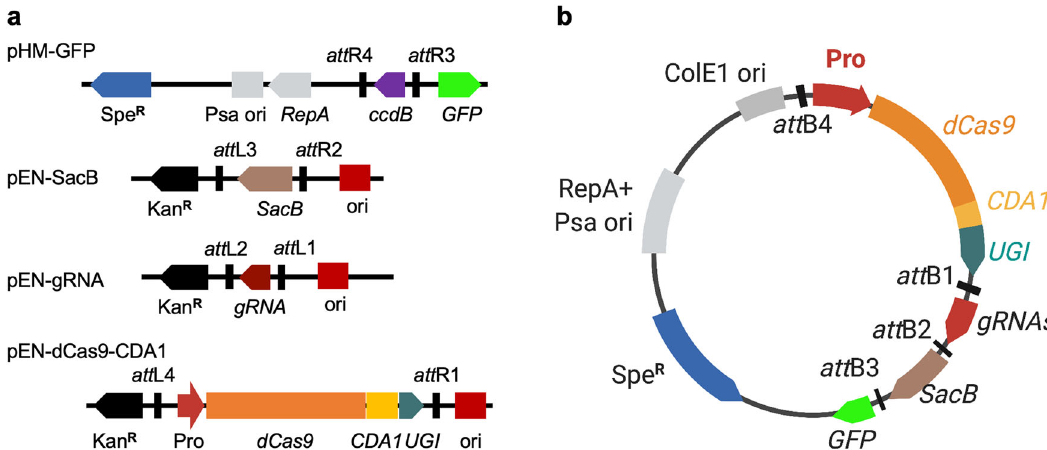
Fig. 1 Phytopathogenic bacterial cytidine base editor system. a A four-module system to make gene speci fi c cytidine base editor. Expression cassettes of guide RNA (gRNA), SacB , and chimeric gene of dead Cas9 (dCas9), cytidine deaminase (CDA1) and DNA uracil glycosylase inhibitor (UGI) each are fl anked by the Gateway recombination motifs ( att R and att L). b Schematic map of single construct expressing dead Cas9 deaminase, guide RNA expression cassette and GFP. Pro, promoter derived from Xanthomonas . dCas9, a nuclease dead Cas9; CDA1 P. marinus cytidine deaminase, UGI uracil DNA glycosylase inhibitor, gRNA guide RNAs, SacB the counter-selectable marker for plasmid curing after editing and GFP driven by E. coli glT promoter. The plasmid contains the spectinomycin-resistant (Spe R ) gene, the pSa origin and RepA, high-copy number origin of